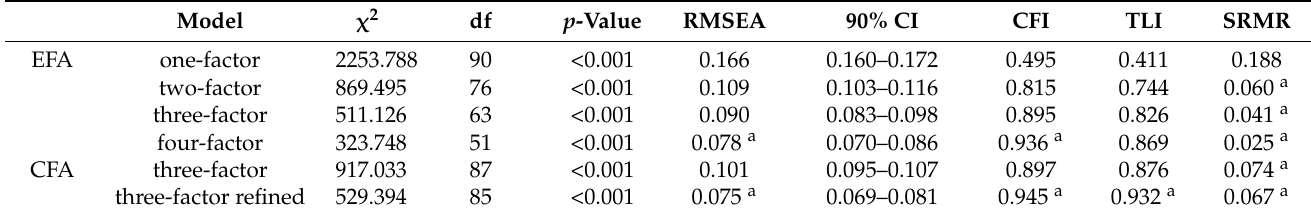
Table 2. Fit statistics for EFA/CFA models.